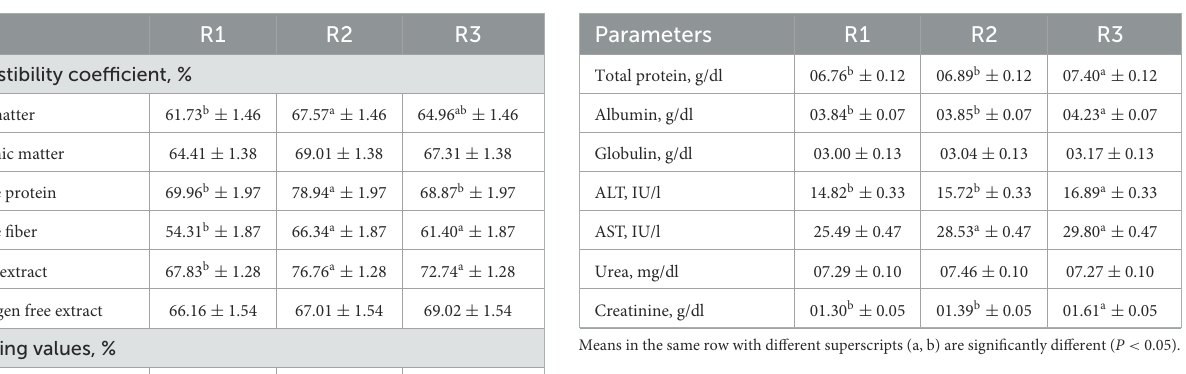
TABLE 3 Effects of including azolla on digestibility coefficients and feeding values of experimental rations.